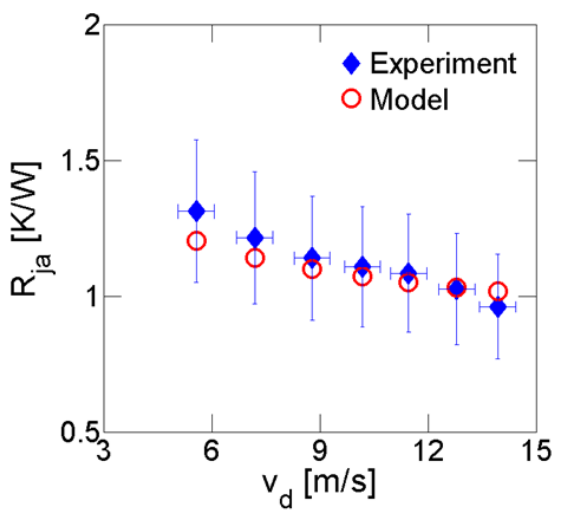
Figure 6. Comparison between experimental results and modeling predictions for the considered commercial heat sink. Experimental error bar values have been estimated relying on similar measurements [44–49]. In particular, see Appendix A in Reference